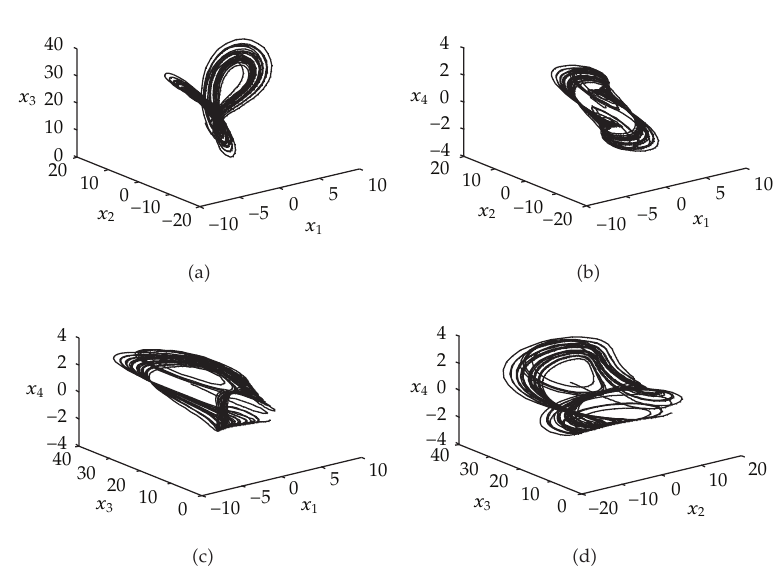
Figure 1: The chaotic attractor of the 4D Lorenz-Stenflo chaotic